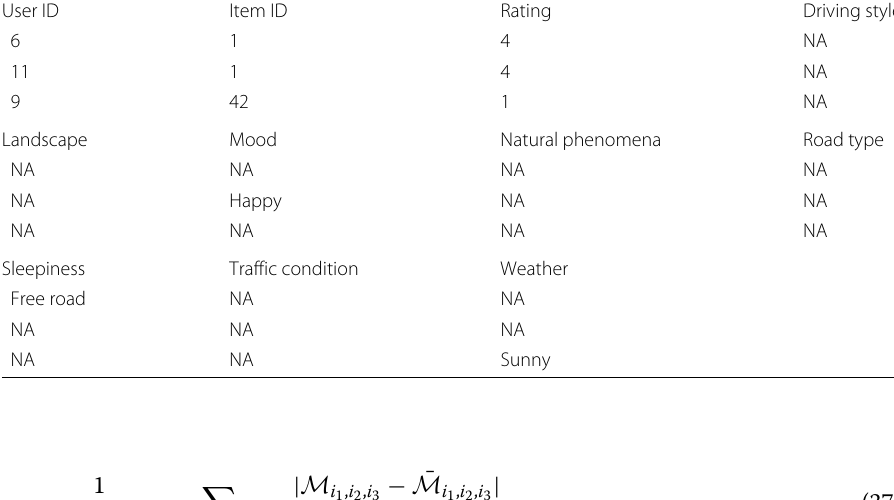
Table 2 Example of the in-car music recommender dataset [16]